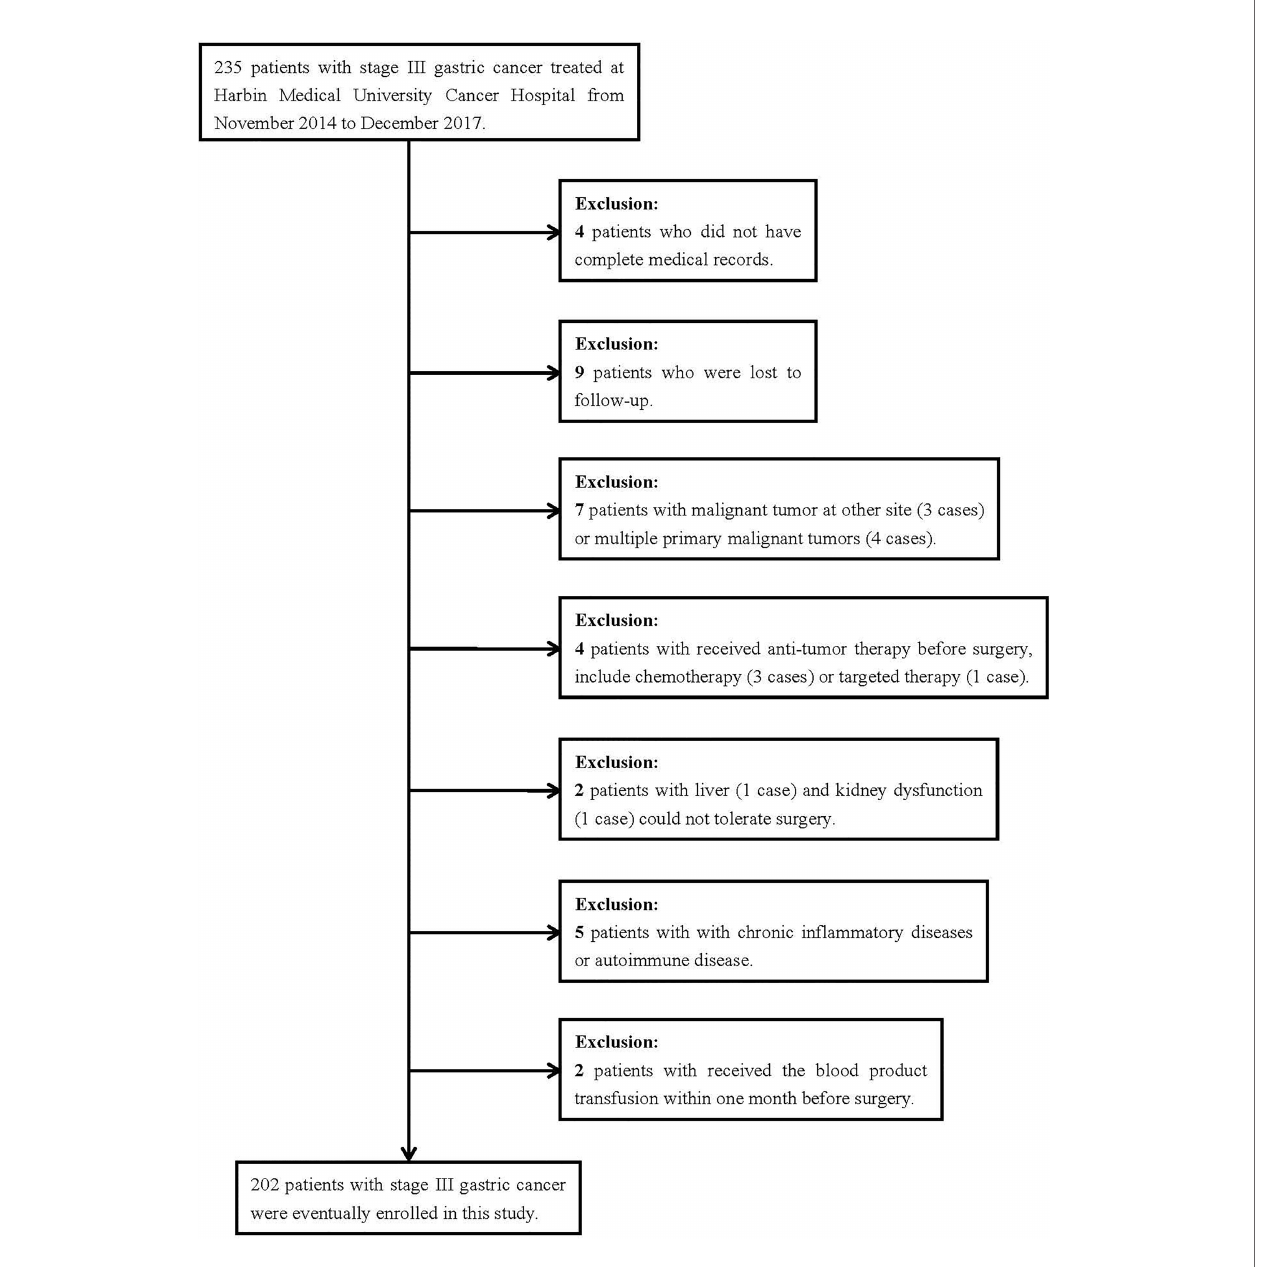
FIGURE 1 | Flow diagram of the process of selection of the patients included in this